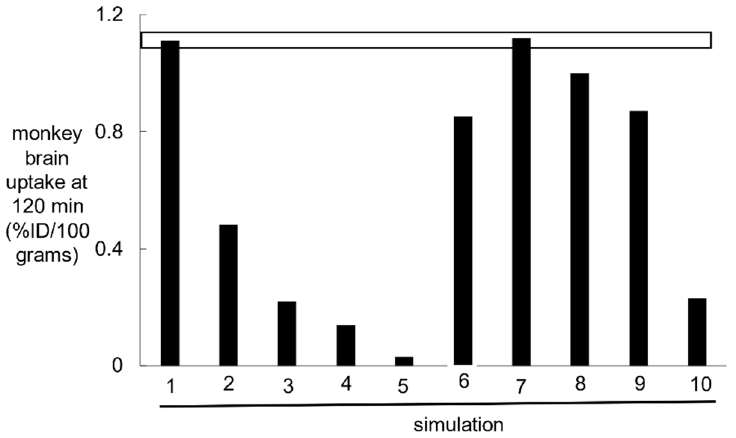
Figure 2. The TfRMAb concentration, expressed as a percent of injected dose (ID) per rhesus monkey simulations 1-10. The 120 min TfRMAb concentrations, in units of nM, are given in Table 3. The